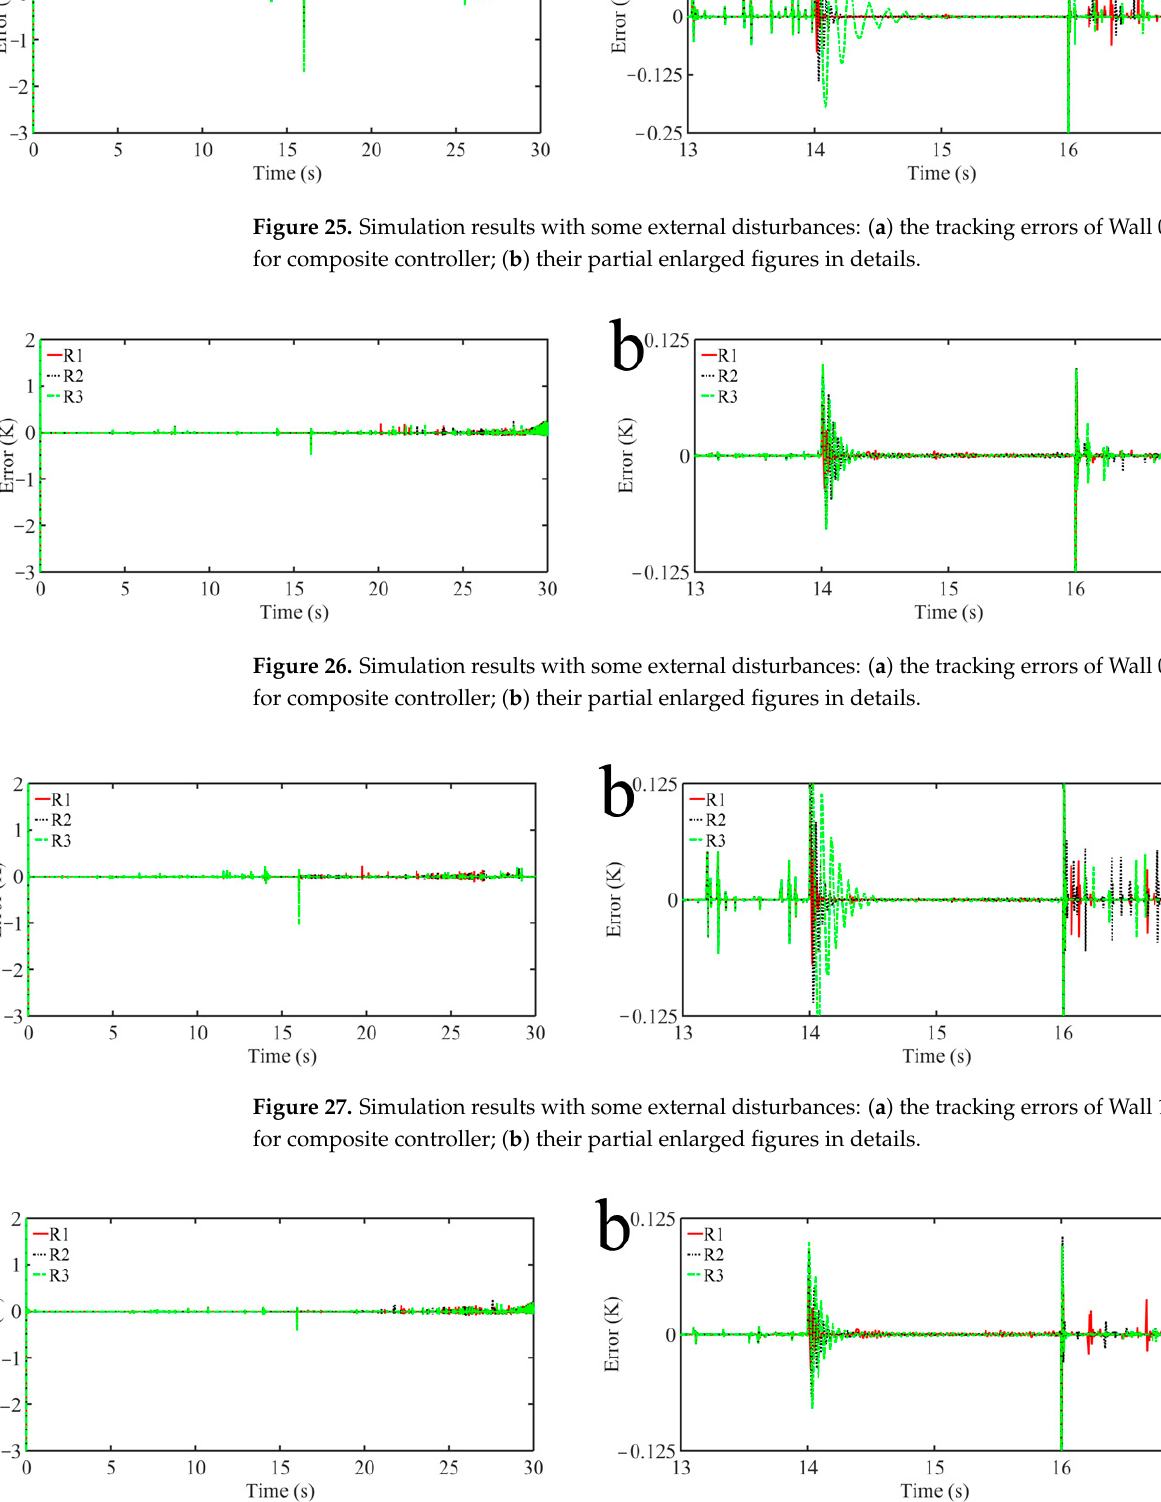
Figure 28. Simulation results with some external disturbances: ( a ) the tracking errors of Wall 1_45 mm for composite controller; ( b ) their partial enlarged figures in